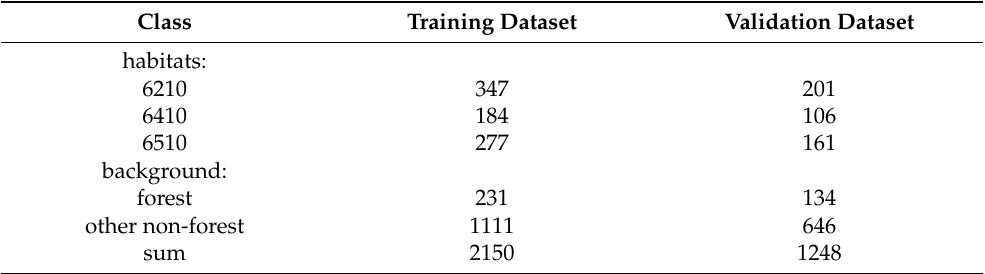
Table 3. Number of pixel samples in each class.